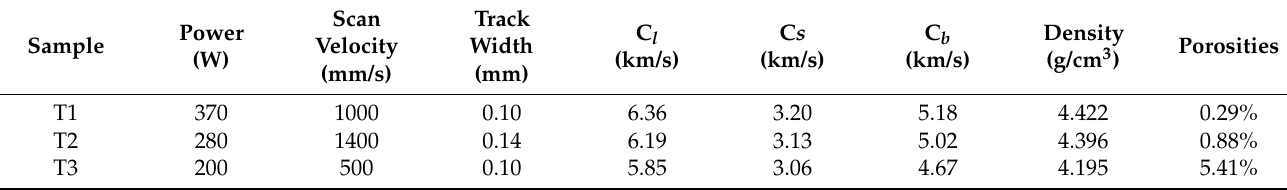
Table 2. Summary of SLM parameters and sample’s porosities and physical parameters. C l , C s , C b represent the longitudinal, shear, and bulk acoustic velocities, respectively.